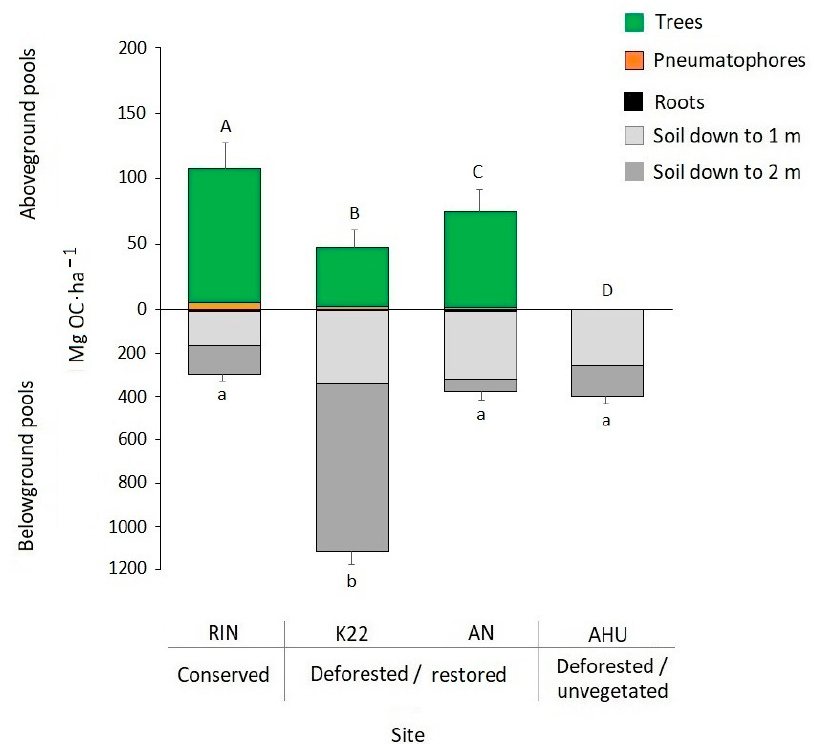
Figure 4. Carbon stocks in aboveground and belowground mangrove pools in Ciénaga Grande de Santa Marta. Note that different scales are shown for aboveground and belowground pools. Different letters represent significant differences among sites in the aboveground and belowground C pools.